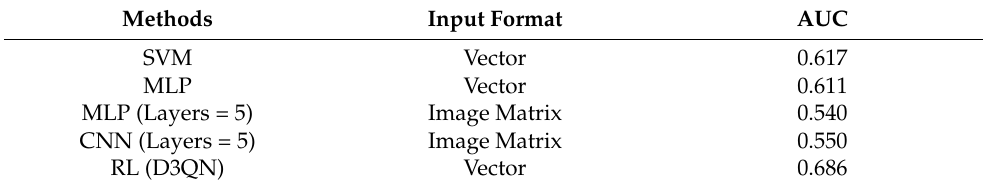
Table 3. Comparison with several methods. AUC evaluates the correctness of the prediction. Methods